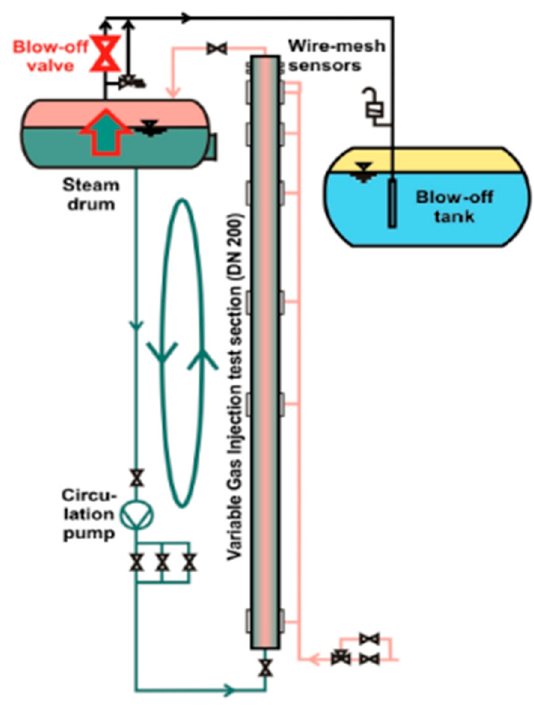
Figure 12. Schema of the experimental procedure.